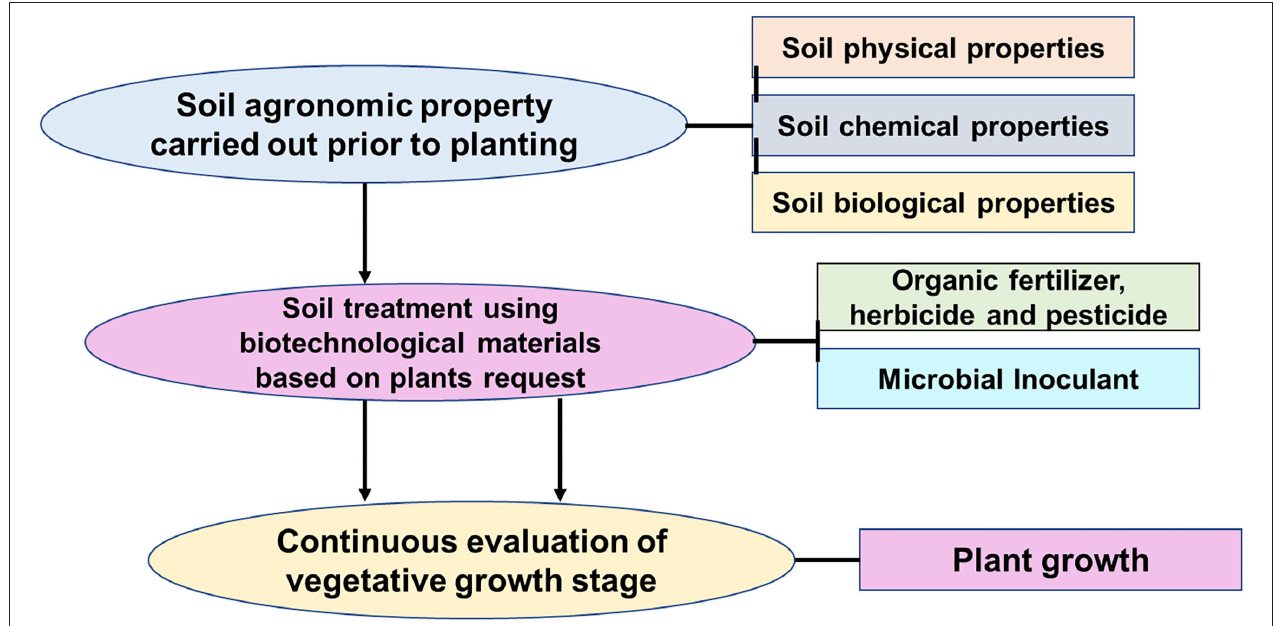
FIGURE 2 | Components that can help achieve sustainable